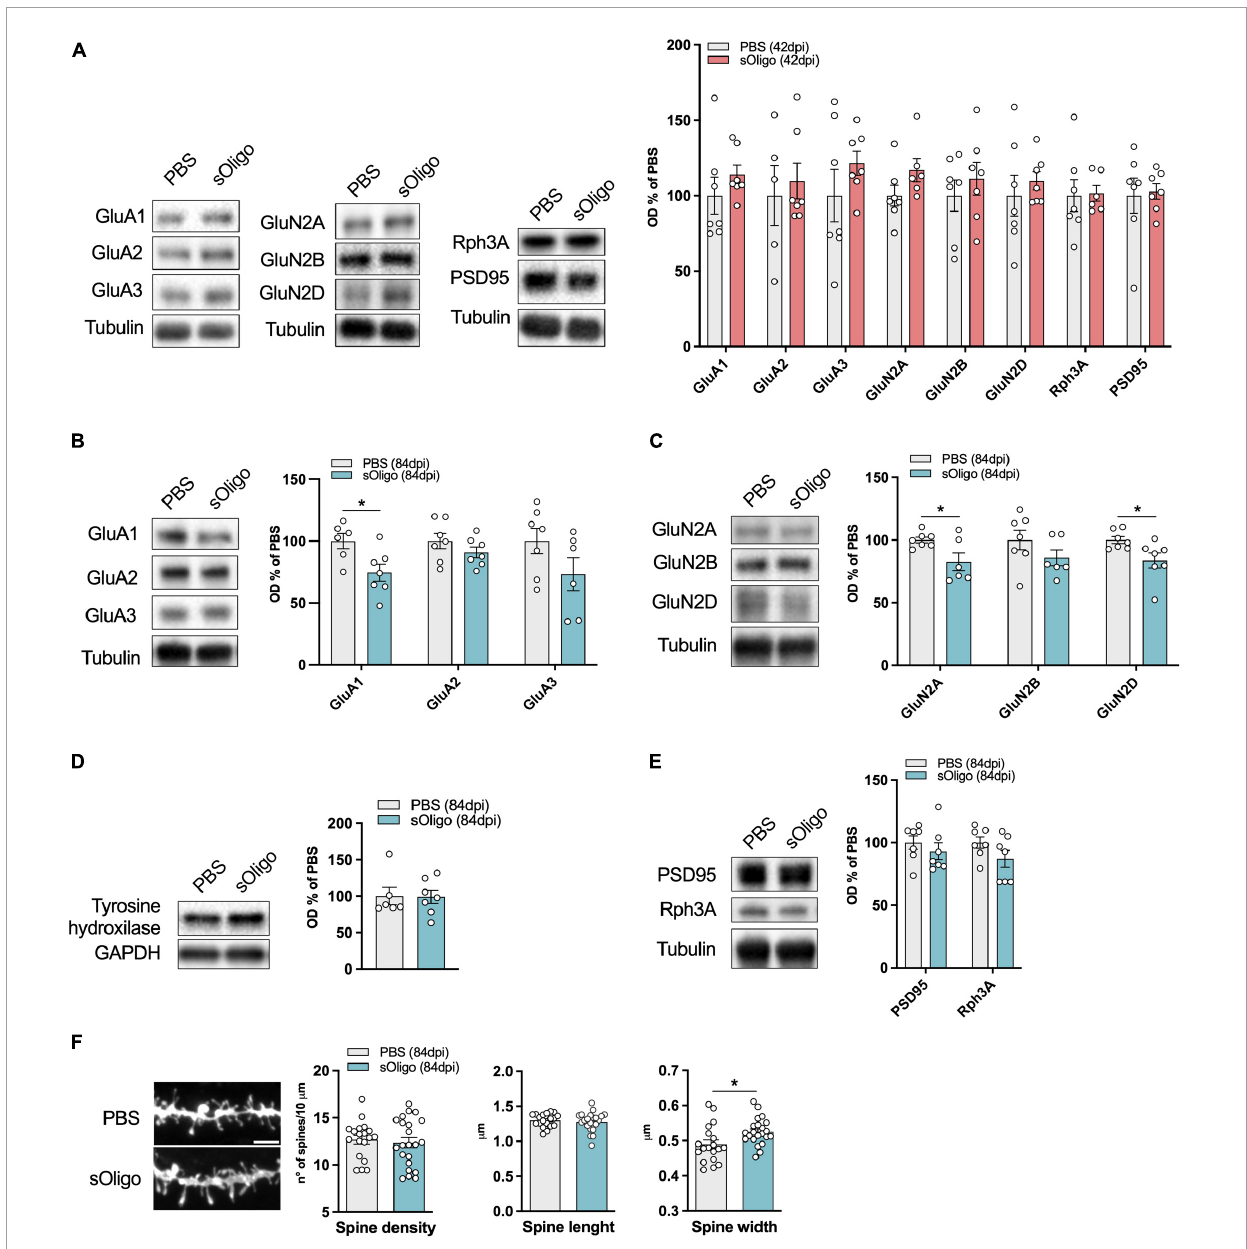
FIGURE2 Molecular effects induced by in vivo striatal injection of α Syn soluble oligomers in mice at the corticostriatal synapse. (A) Post-synaptic levels of AMPAR (GluA1, GluA2, and GluA3) and NMDAR (GluN2A, GluN2B, and GluN2D) subunits and scaffolding proteins (Rph3A and PSD95) were evaluated by Western blot in striatal TIF of sOligo- and PBS-injected mice 42 dpi. Protein levels normalized on tubulin were reported as OD% of PBS-mice. n = 5–7 mice. Post-synaptic levels of (B) AMPAR (GluA1, GluA2, and GluA3) subunits, (C) NMDAR (GluN2A, GluN2B, and GluN2D) subunits and (E) scaffolding proteins (Rph3A and PSD95) were evaluated by Western blot in striatal TIF of sOligo- and PBS-injected mice 84 dpi. Protein levels normalized on tubulin were reported as OD% of PBS-mice. n = 5–7 mice. (D) Expression of the dopaminergic marker Tyrosine hydroxylase was evaluated by Western blot in striatal homogenates of sOligo- and PBS-injected mice 84 dpi. Protein levels normalized on GAPDH were reported as OD% of PBS-mice. n = 7 mice. (F) Representative confocal images and quantification of spine morphology analyses (spine density, spine length and spine width) of SPNs of sOligo- and PBS-injected mice 84 dpi. Scale bar: 3 µ m. n = 19–22 neurons from 3 mice. Data are represented as mean ± SEM. * P < 0.05 (Student’s t -test; data with non-normal distribution were tested with Mann–Whitney